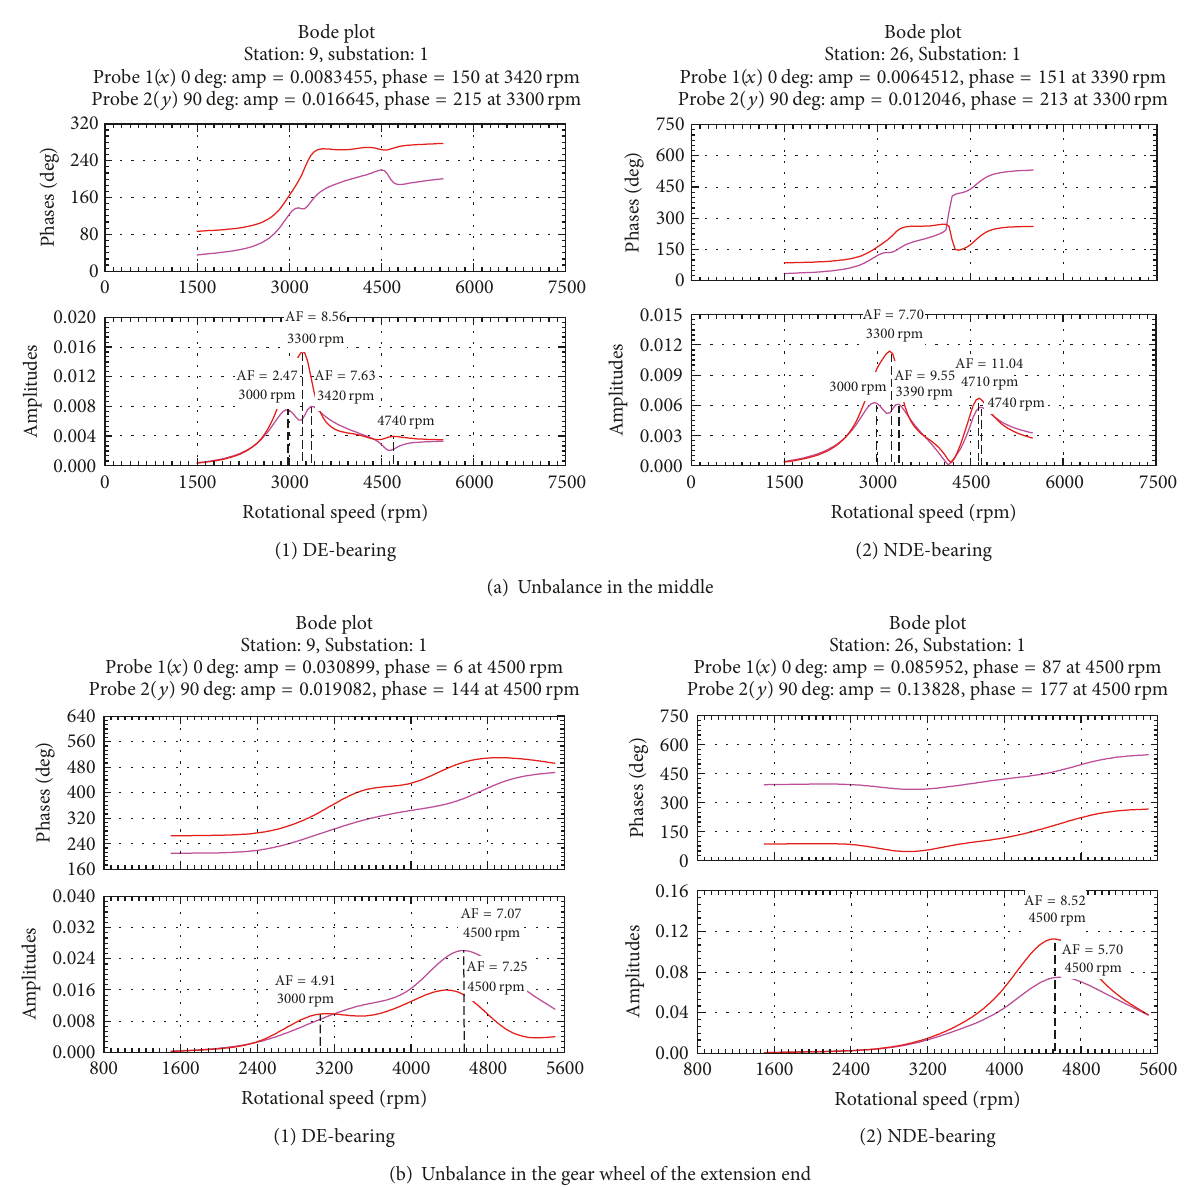
Figure 3: The bode charts of unbalanced response of four-lobe